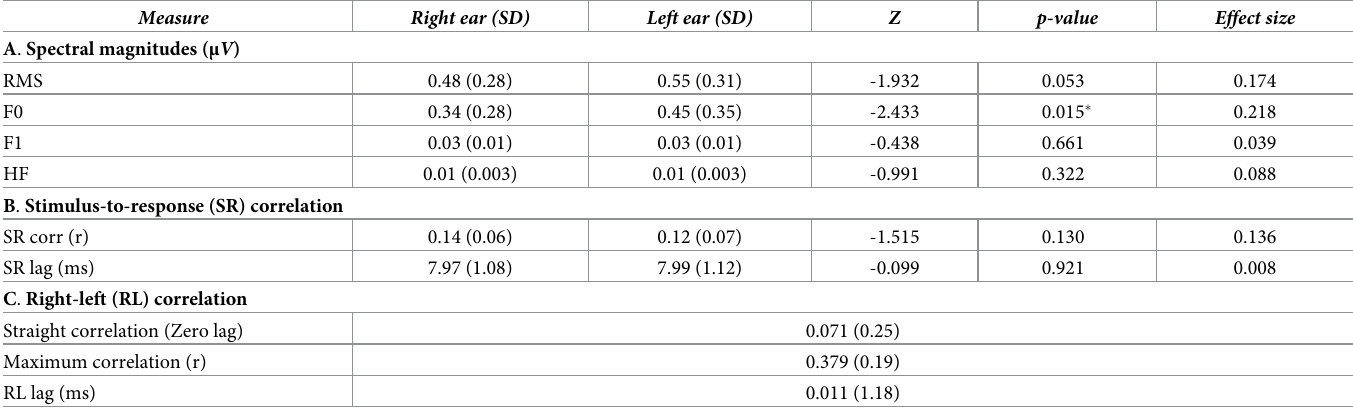
Table 3. Mean and standard deviation (SD) values of (A) spectral magnitude measures, (B) stimulus-to-response correlation for right and left ears and (C) right- left correlation for all participants (n = 62). Measure Right ear (SD) Left ear (SD) Z p-value Effect